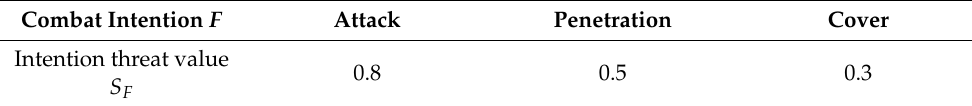
Table 4. Combat intention threat